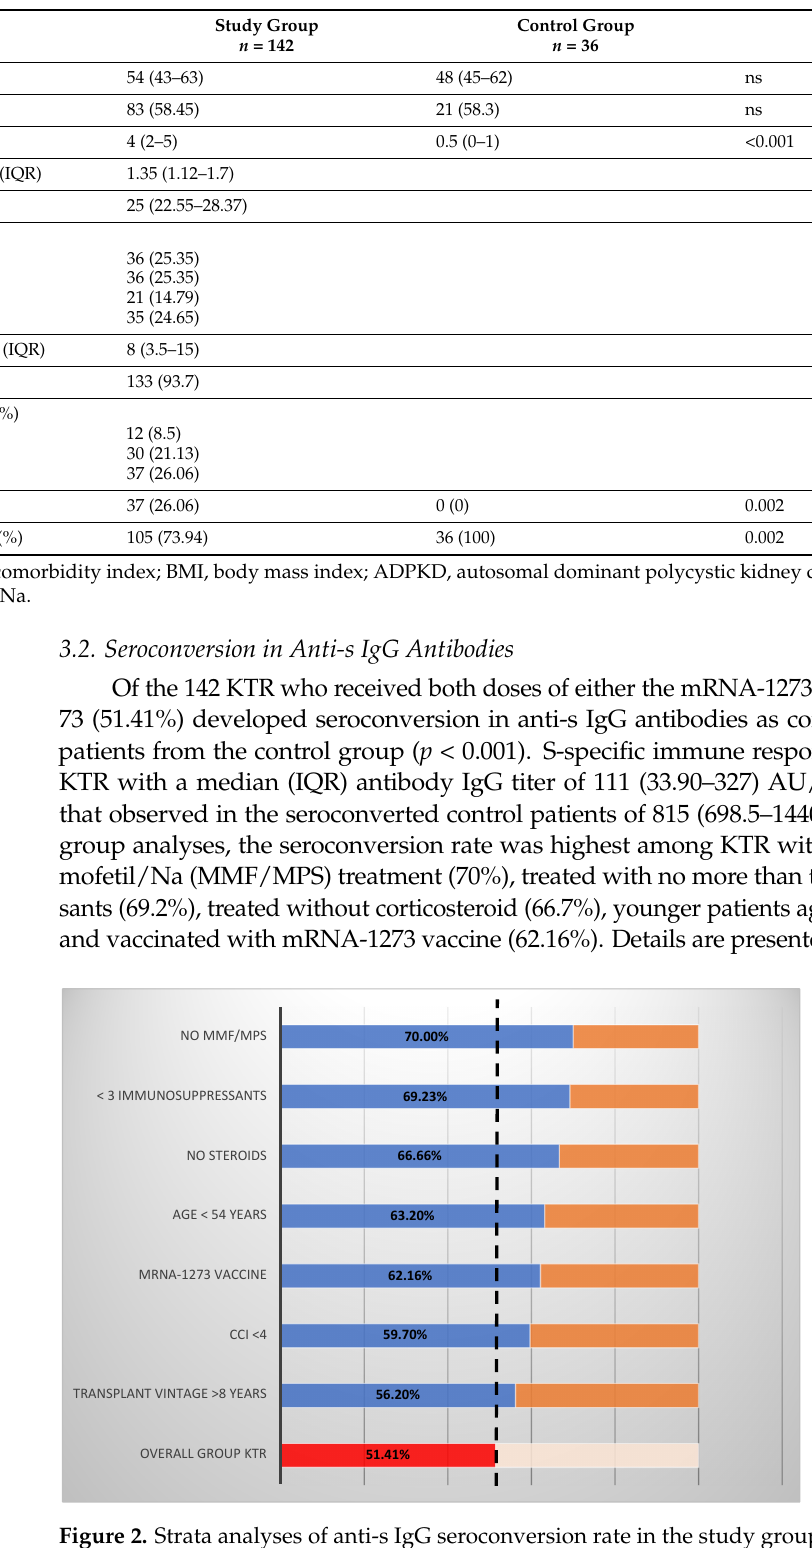
Table 1. Demographic and clinical characteristic study and control group.